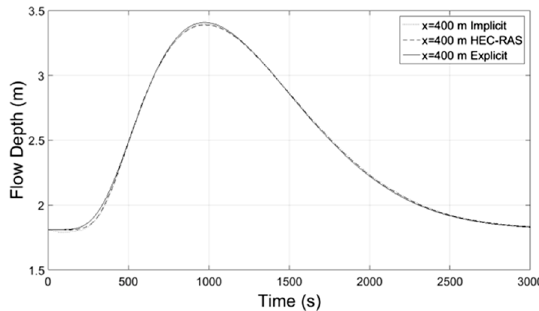
Figure 17. Average Velocity-Time at x = 267 m.